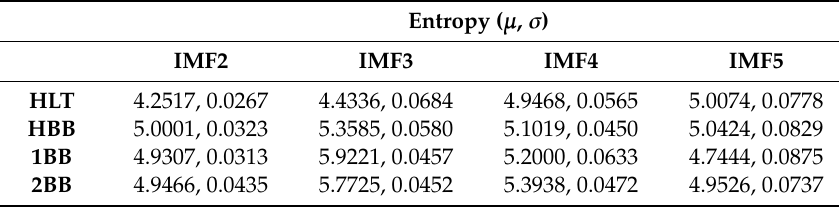
Table 3. Mean ( µ ) and standard deviation ( σ ) for the entropy values.